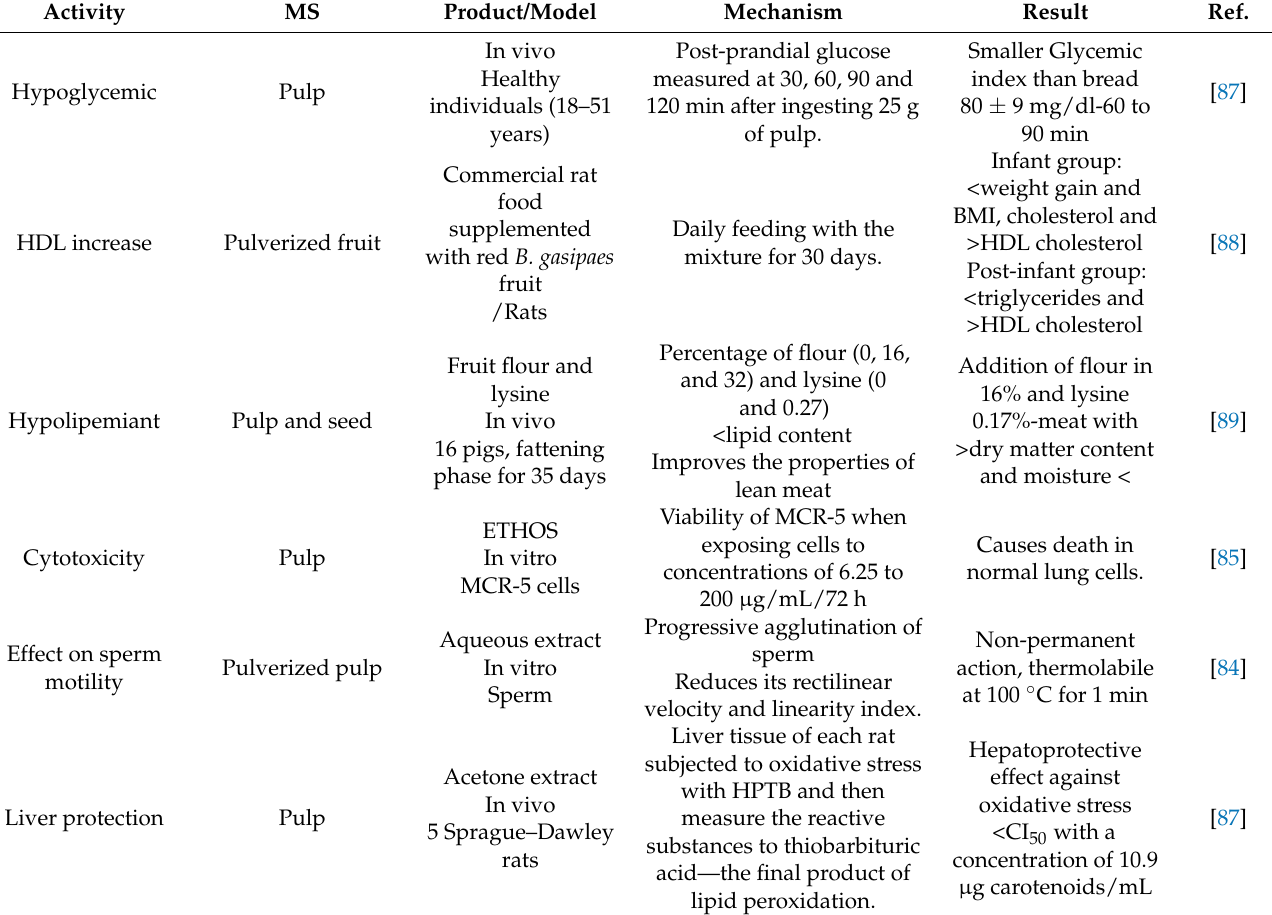
Table 7. Biological activity of Bactris gasipaes